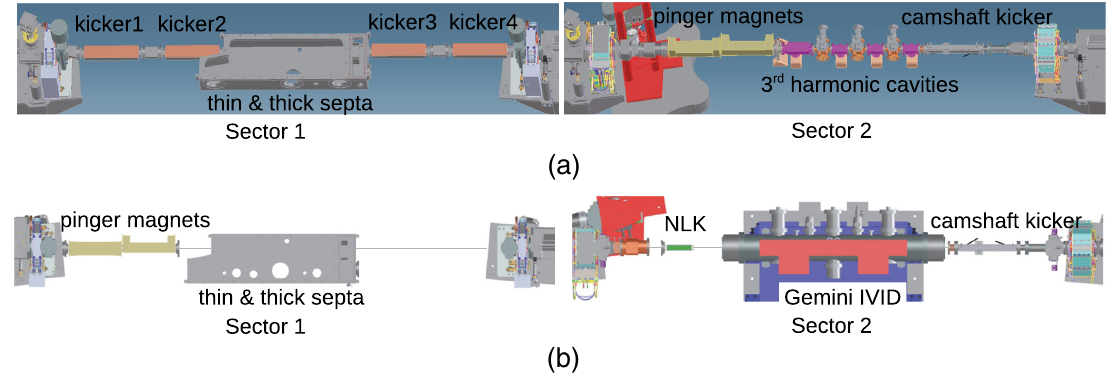
FIG. 3. Layout of sector 1 and sector 2 straights before (a) and after (b) the melioration of the ALS injection system.